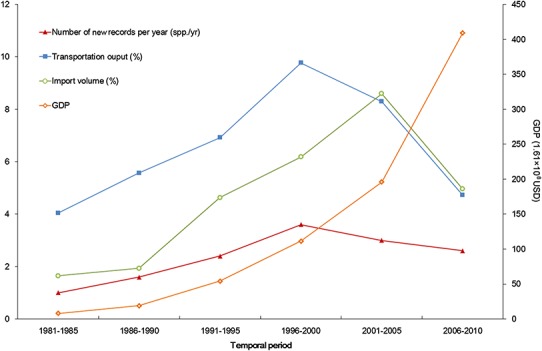
Trends of alien animal introduction and GDP, transportation development, and foreign trade.The x-axis begins with 1981 as systematic statistics in Xinjiang did not start until 1978.